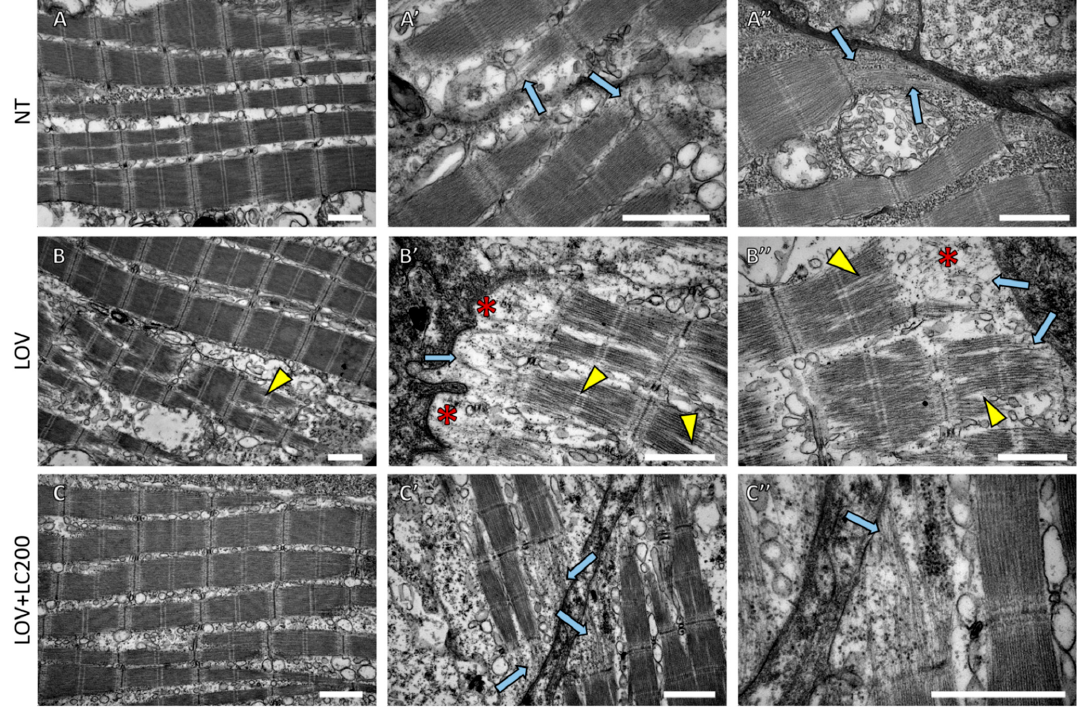
Figure 2. Ultrastructural analysis of skeletal muscles of 120 hpf zebrafish larvae exposed to lovastatin (LOV) and L ‐ carnitine (LOV+LC200) treatment. TEM micrographs show ( A ), ( A’ ), and ( A’’ ) NT (non ‐ treated larvae); ( B ), ( B’ ), and ( B’’ ) LOV (0.5 μ M lovastatin); ( C ), ( C’ ), and ( C’’ ) larvae incubated in a mixture of LOV+LC200 (0.5 μ M lovastatin and 200 μ M L ‐ carnitine). Light blue arrows indicate sarcomeric filaments within subsarcolemmal regions; yellow arrowheads indicate delamination of filaments within sarcomeres; note the disruption of sarcomeric filaments in skeletal muscles of lovastatin ‐ treated larvae (red asterisks); scale bar = 1 μ m. 3.3. Lovastatin Treatment Stimulates Atrogin ‐ 1 Expression in Zebrafish Larvae While L ‐ carnitine Has a Protective Effect Elevated atrogin ‐ 1 level is considered an indicator of muscle atrophy. Statin ‐ induced muscle damage has also been associated with an increase in muscle atrogin ‐ 1 expression. This phenomenon was observed in, inter alia, zebrafish embryos exposed to these compounds [7]. Therefore, we decided to investigate whether atrogin ‐ 1 expression is also increased in 120 hpf zebrafish larvae treated with lovastatin. Our results obtained using real ‐ time quantitative PCR (RT ‐ qPCR) confirmed that the mRNA atrogin ‐ 1 expression level increased significantly after lovastatin administration in comparison to all control groups (Figure 3).